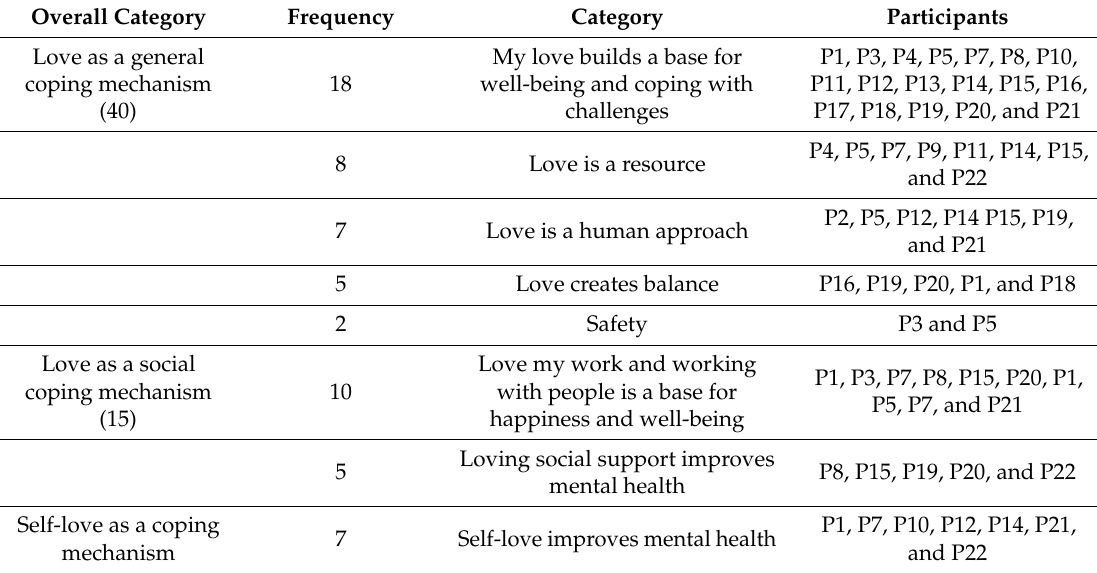
Table 5. Love as a coping